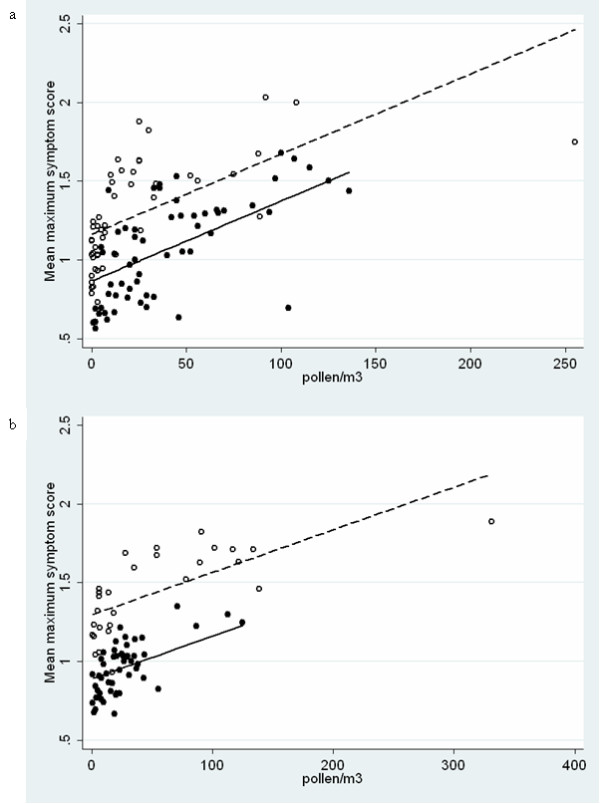
Scatter plot of the daily mean of the maximum symptom score and the pollen concentrations in the early (open circles) and the late season (closed circles) of 2007 (a) and 2008 (b). Regression lines are shown for the early season (dashed line) and for the late season (solid line).